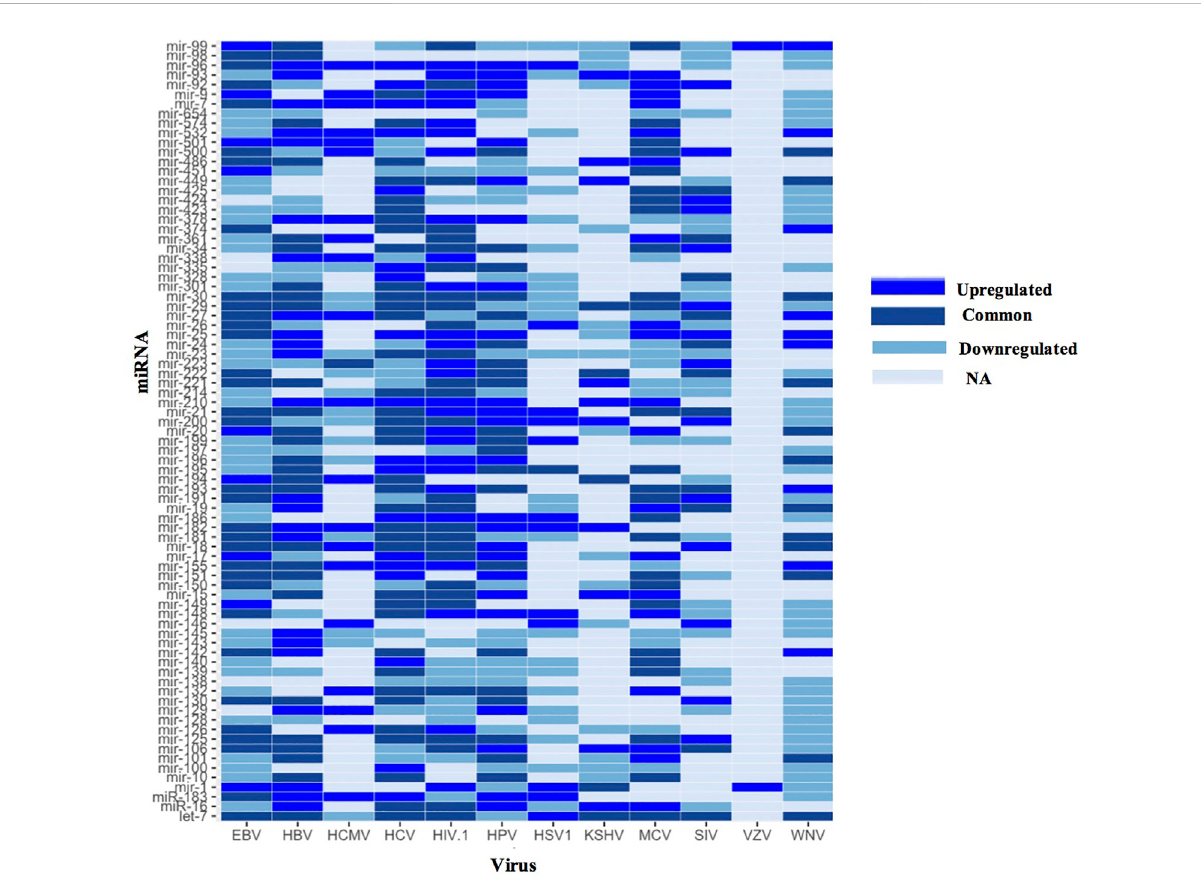
FIGURE 3 Heatmap showing human miRNA expression reported in different viruses (EBV, Epstein Barr virus; HBV, Hepatitis B virus; HCMV, Human cytomegalovirus; HIV, Human immunode fi ciency virus; HPV, Human Papillomavirus; HSV1, Herpes simplex virus one; KSHV, Kaposi sarcoma- associated herpesvirus; MCV, Merkel cell polyomavirus; SIV, Simian immunode fi ciency virus; VZV, Varicella-zoster virus and WNV, West Nile